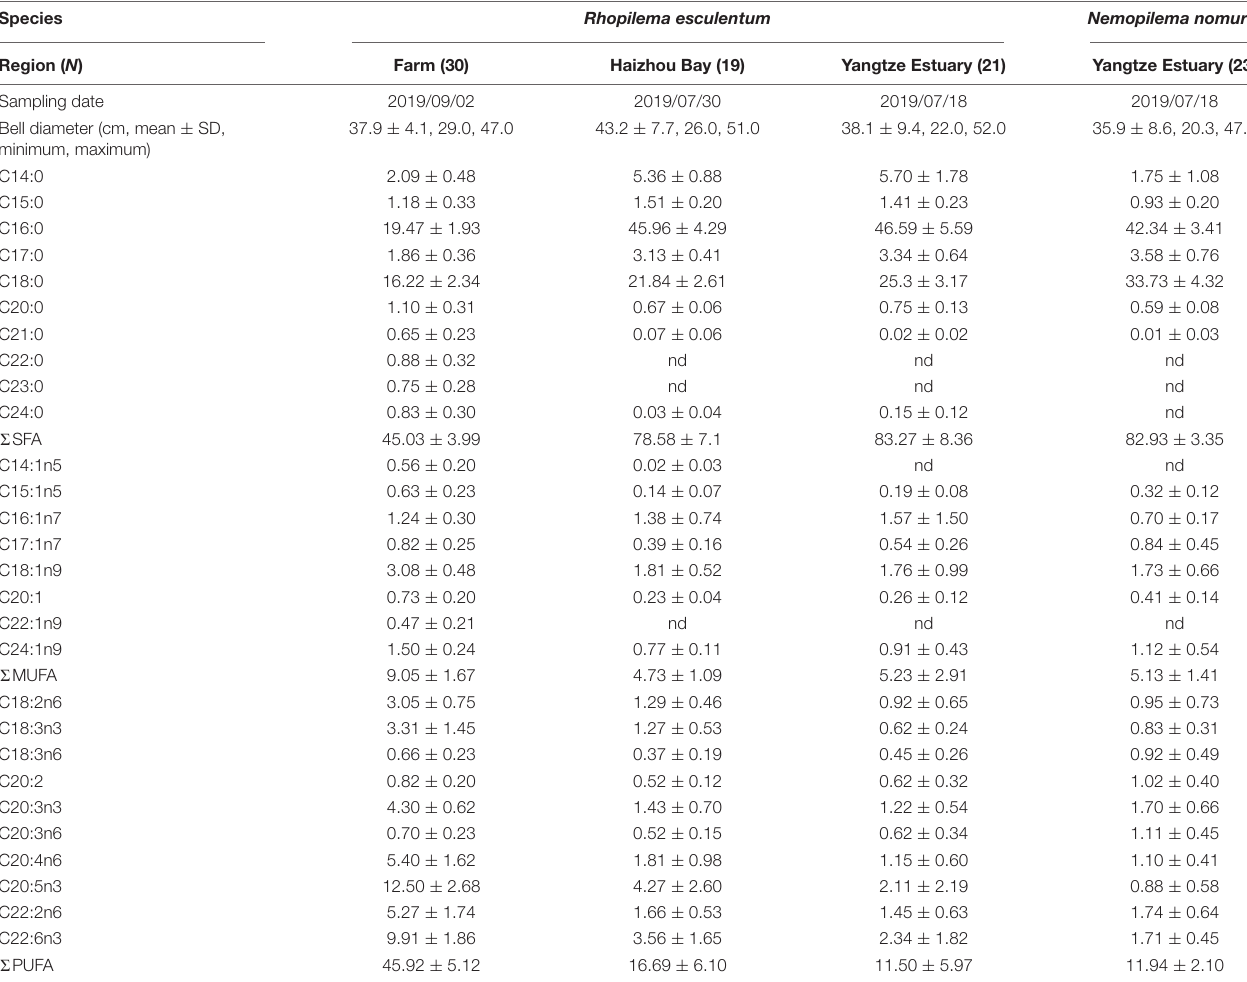
TABLE 1 | Specimen characteristics and fatty acid profiles of the bell tissues of Rhopilema esculentum collected from three regions and Nemopilema nomurai collected from Yangtze Estuary. Species